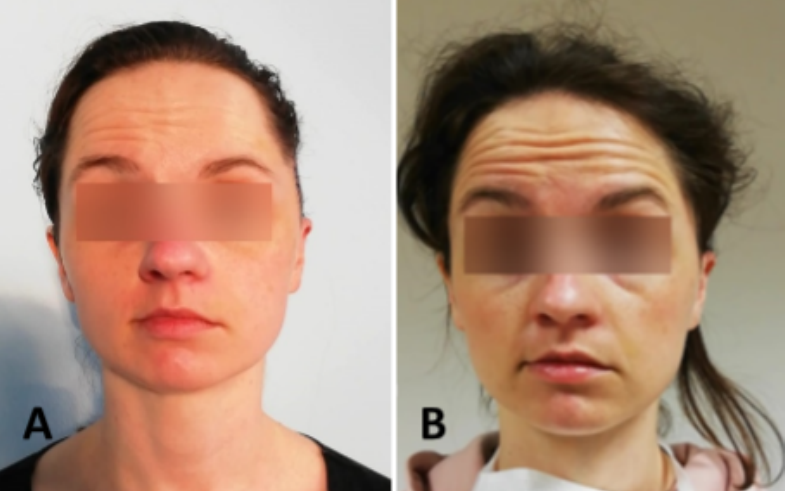
Figure 9. Patient with facial nerve dysfunction raising the eyebrows; ( A ) HB6—no movement on the left side; ( B ) HB3—moderate movement.